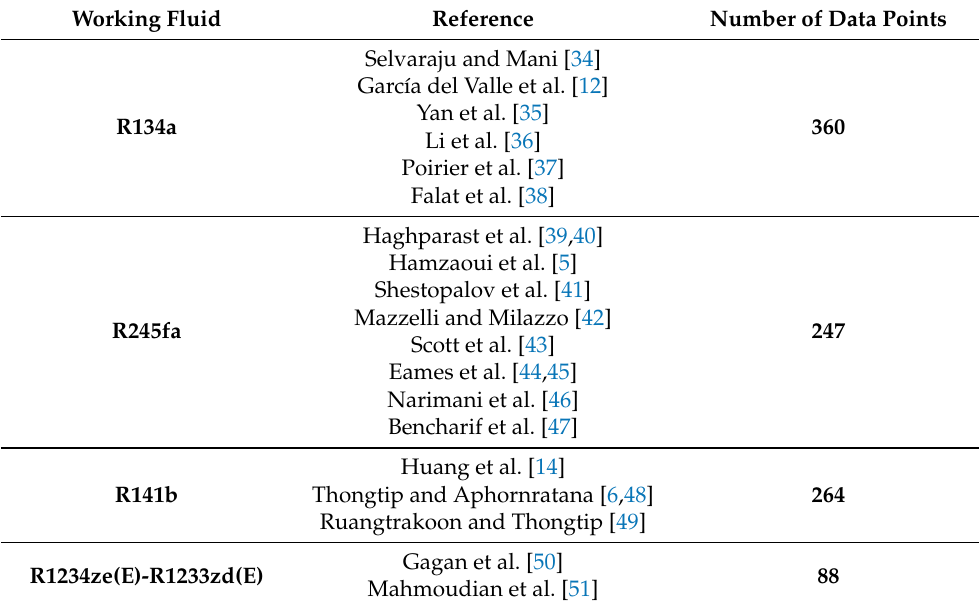
Table 1. Experimental studies on ejector refrigeration systems gathered for the construction of the database.